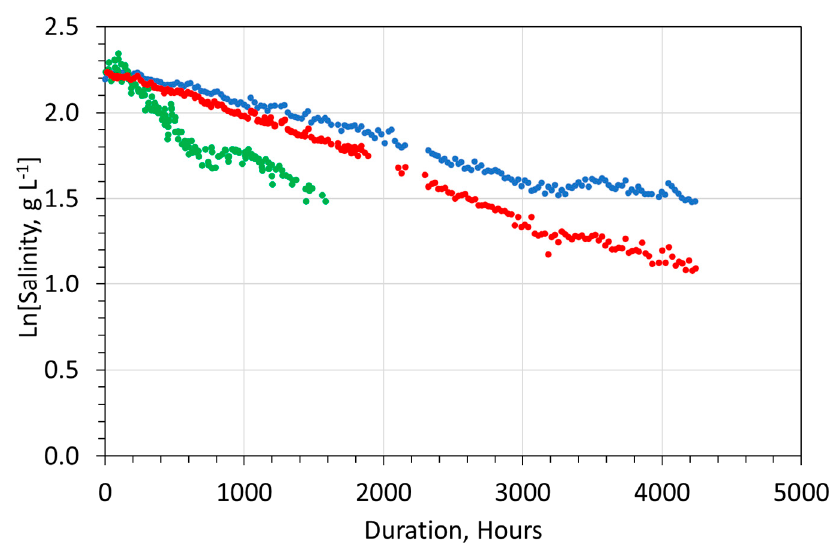
Figure A5. Comparison of three different types of desalination pellet: Red markers = m-Fe 0 :n- Fe(b)@n-C 0 polymer, where the n-C 0 is created within the ZVI Reactor during manufacture (Ap- proach A); blue markers = m-Fe 0 :n-Fe(b)@n-C 0 polymer, where the n-C 0 is added to a ZVI Reactor during manufacture (Approach B); green markers = n-Fe(b)@bluecrop polyphenol@C 0 polymer pel- lets created in this study.